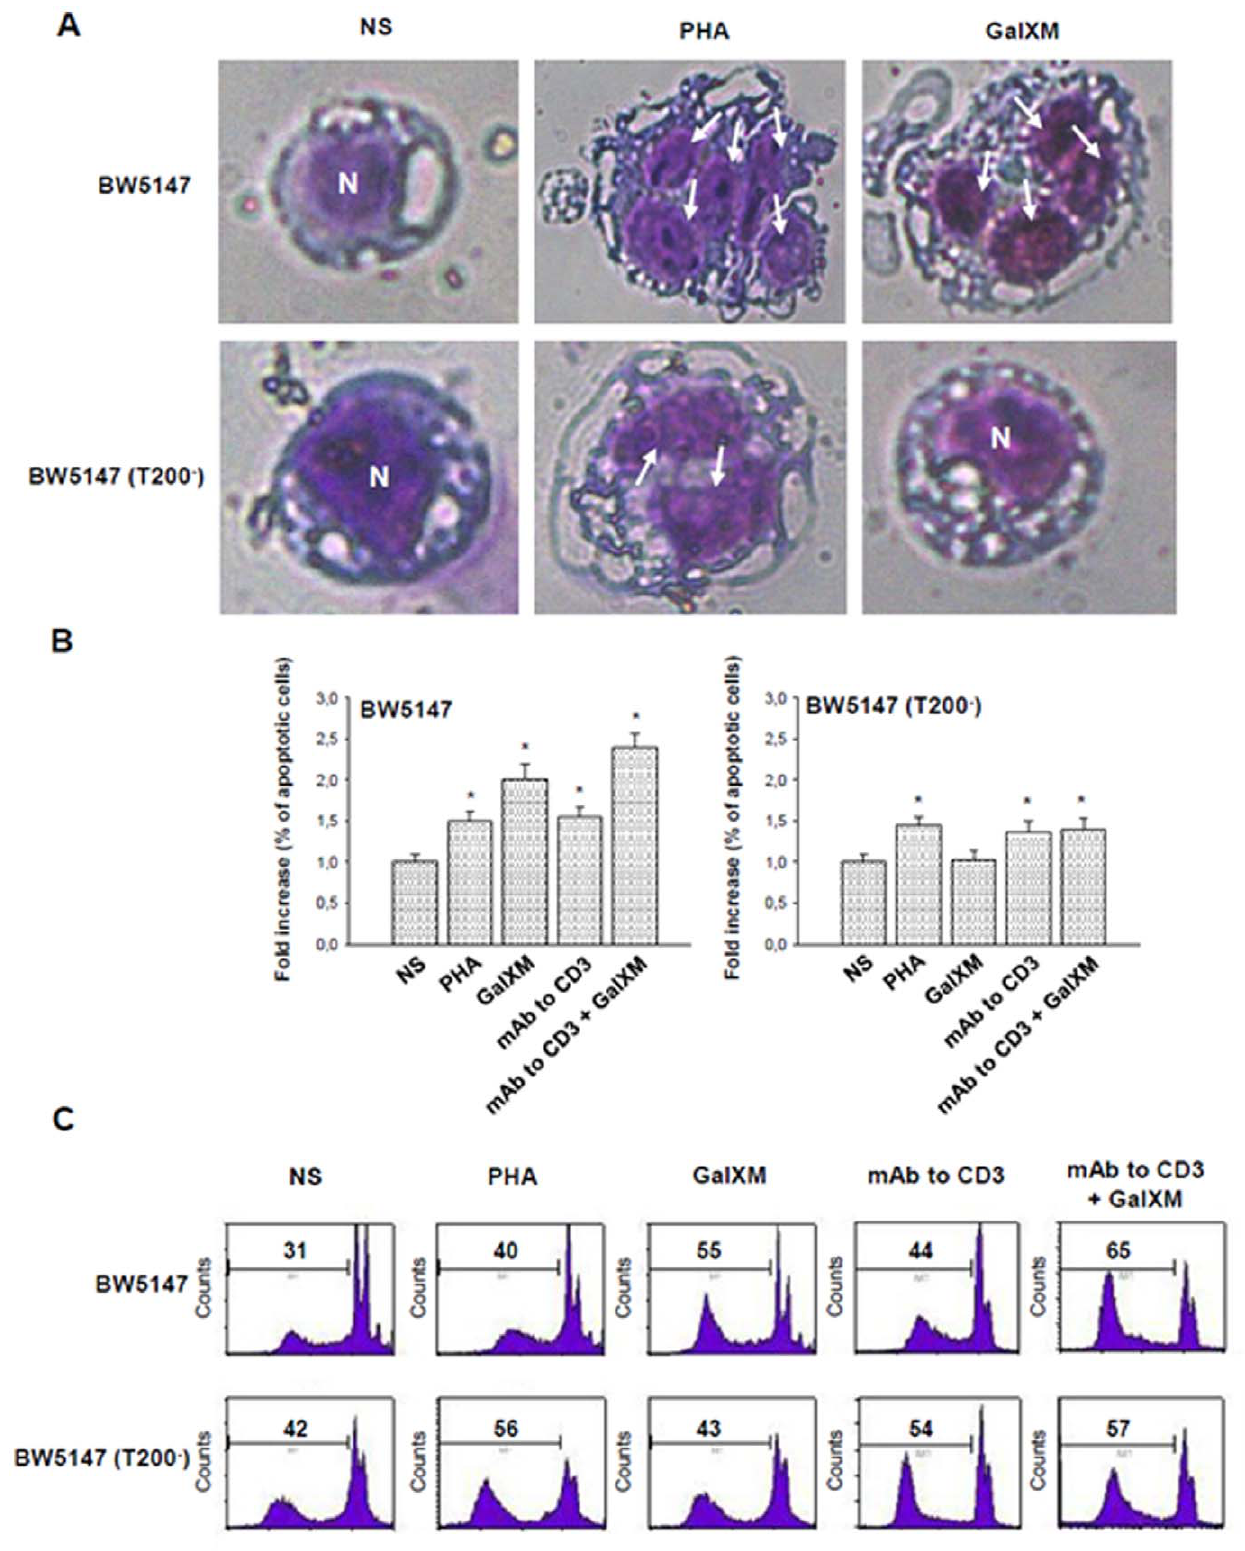
Figure 4. GalXM-induced apoptosis of BW5147 cells. ( A ) BW5147 and BW5147 (T200 2 ) cells (both 1 6 10 6 /ml) were incubated for 18 h in the presence or absence (NS) of PHA (10 m g/ml) or GalXM (10 m g/ml). After incubation, cells were collected by cytospin and stained by Hemacolor. GalXM-treated cells exhibited altered morphology, surface blubs and nuclear fragmentation (arrows). N=cell nucleus; original magnification 40x. In selected experiments, cells were incubated for 18 h in the presence or absence (NS) of PHA (10 m g/ml), mAb to CD3 (1 m g/ml) or GalXM (10 m g/ml).